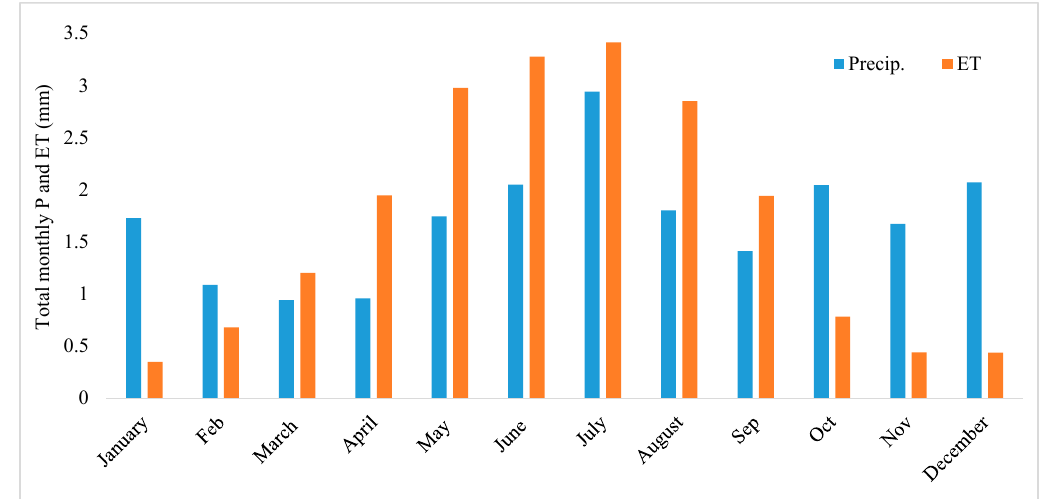
Figure 4. ( Up ) Catchment area under each climate station by using Thiessen polygon interpolation method; and ( Down ) average monthly precipitation and evapotranspiration at Demmin from 2010 to 2017.